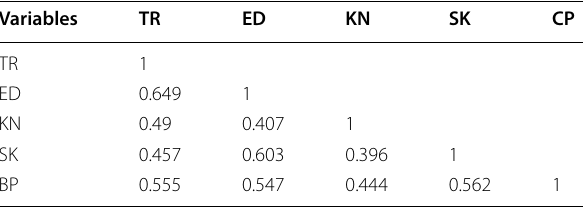
The correlation matrix represents correlation among the latent variables based on extracted factor values through confirmatory factor analysis (CFA)